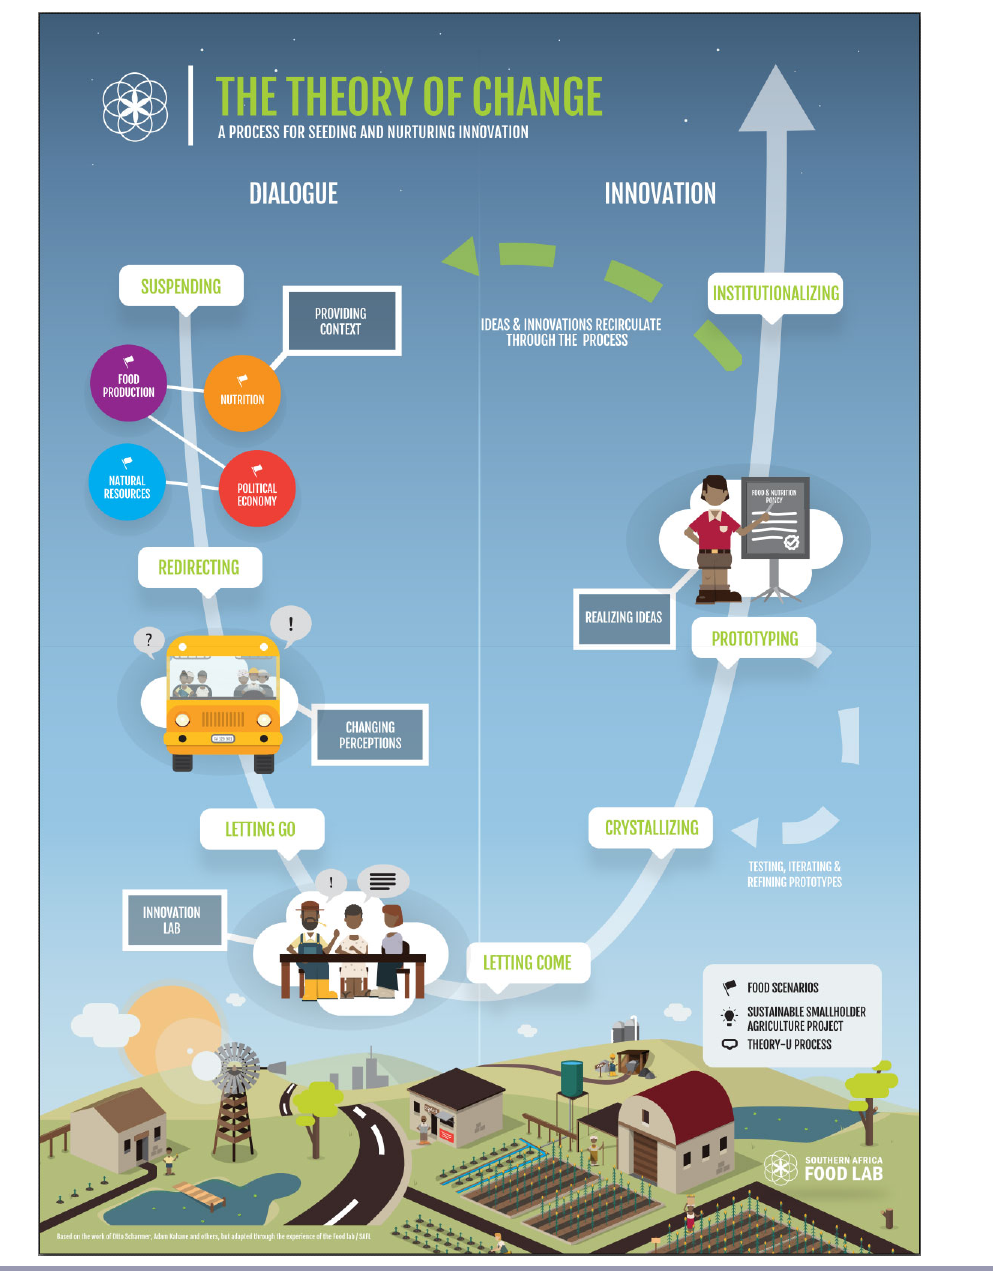
Fig. 1 . The “U” process as adapted from Scharmer (2009) and applied in the Food